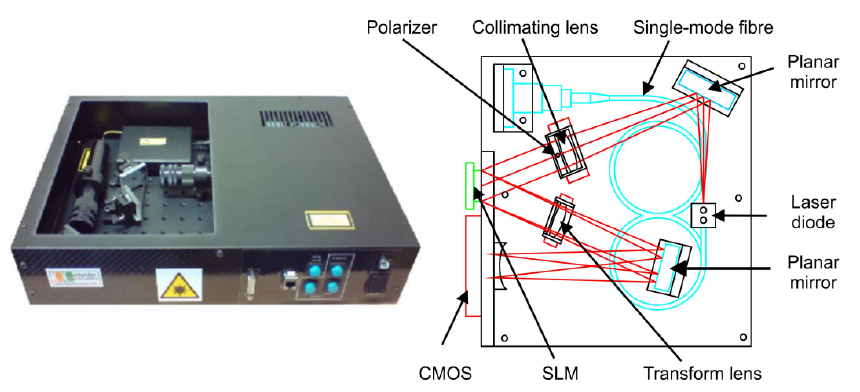
Figure 4. The Cambridge optical correlator